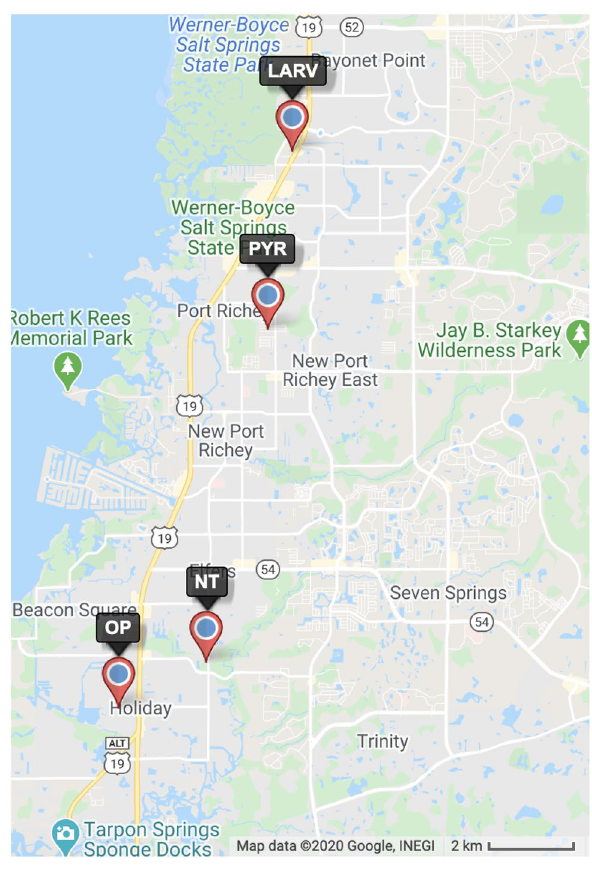
Fig. 1 Approximate locations of treatment sites in Pasco County, Florida. Map created using Maptive